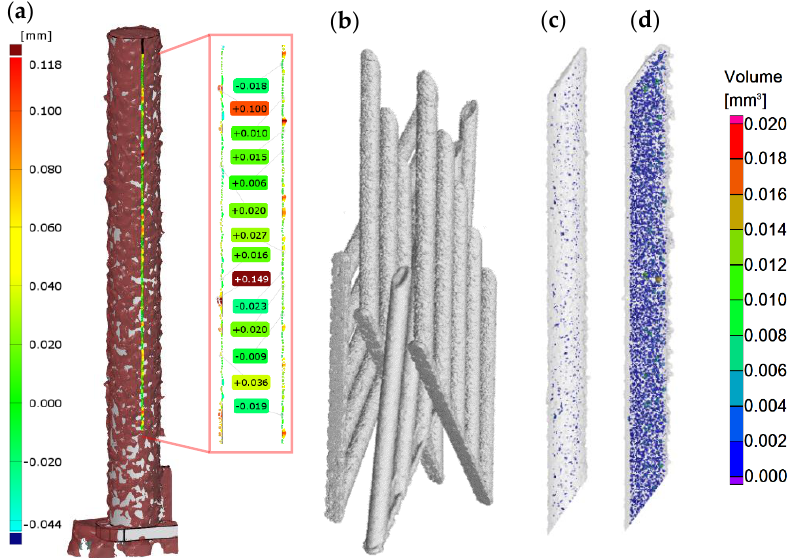
Figure 2. The samples after basic grinding to the struts mid-plane; ( a ) the top view images captured by light microscope; ( b ) three areas of the struts after converting of the colors in ImageJ software.